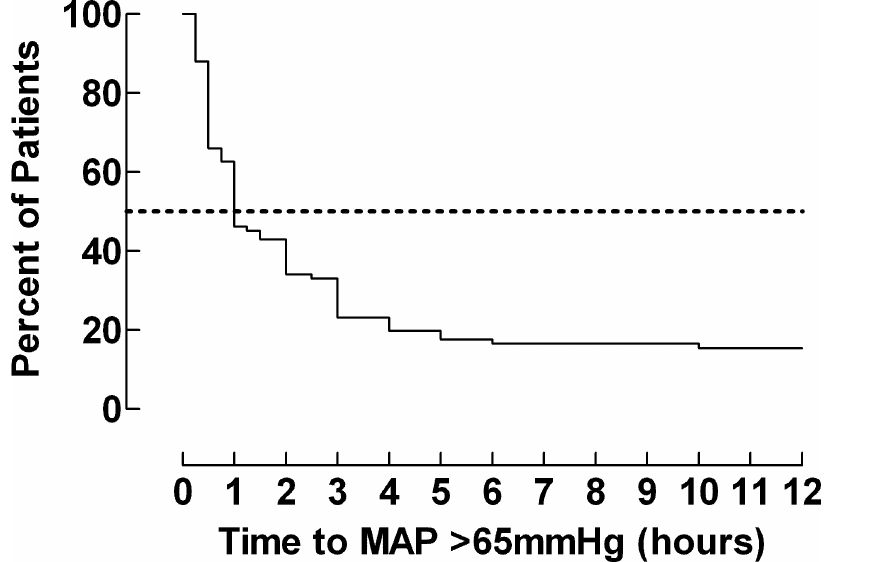
Fig 4. Kaplan-Meier curve describing time to MAP >